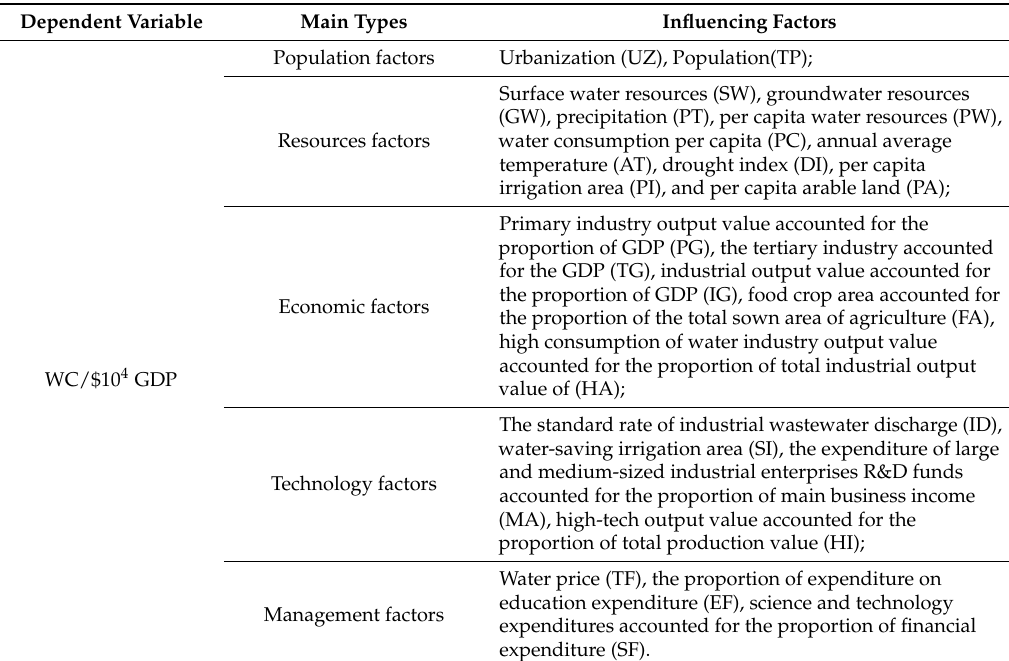
Table 1. Influencing factors’ structure table of WC/$10 4 GDP.